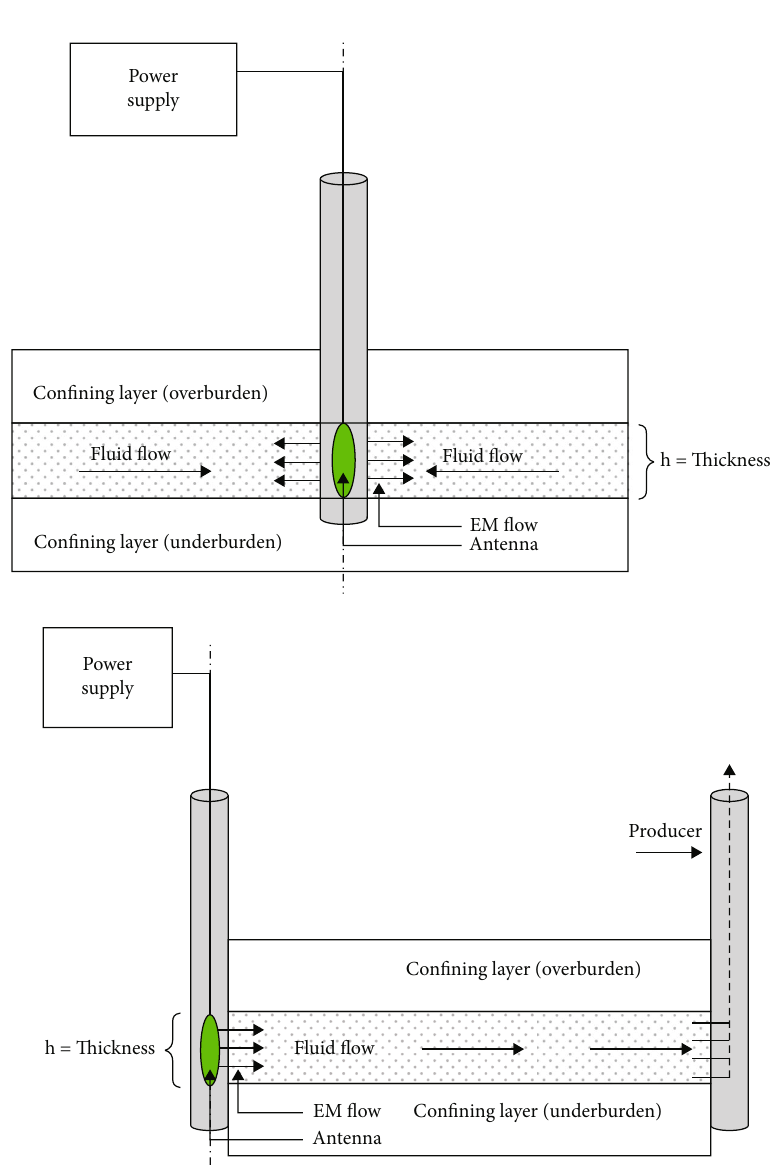
Figure 2: Diagram of the placement of a microwave device in a production well